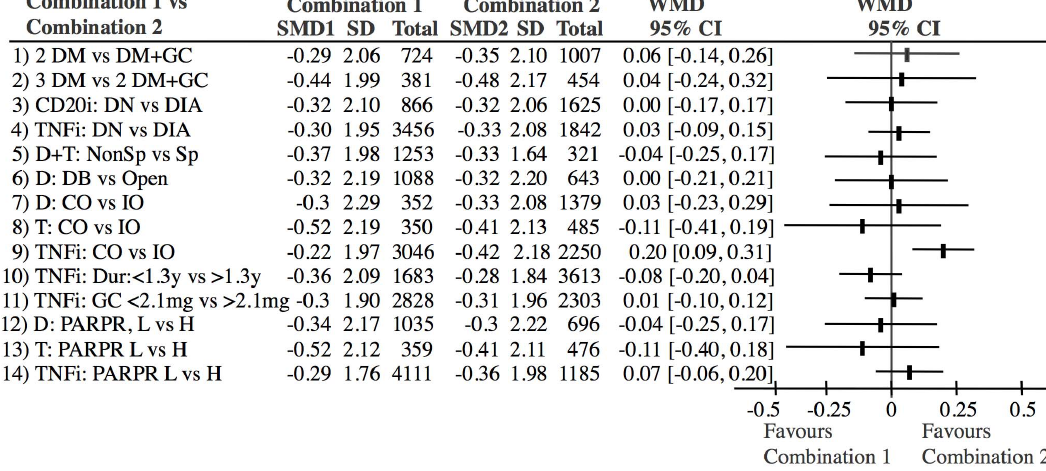
Figure 12. Analyses of bias factors and confounders, which differed significantly across treatment groups. Only 1 bias factor (TNFi studies: Complete outcome versus incomplete outcome, line 9) had a significant influence on the outcome. Abbreviations: SMD: Standardized mean difference. WMD: Weighted mean difference (SMD1-SMD2); DM: DMARD; GC: Glucocorticoid; DN: DMARD naive; DIA: DMARD inadequate responder; D: double; T: Triple; Sp: Sponsoring; DB: double-blind; CO: Complete outcome; IO: Incomplete outcome; Dur: Disease duration at baseline; PARPR: Percentage of annual radiographic progression rate; L: low; H: High.